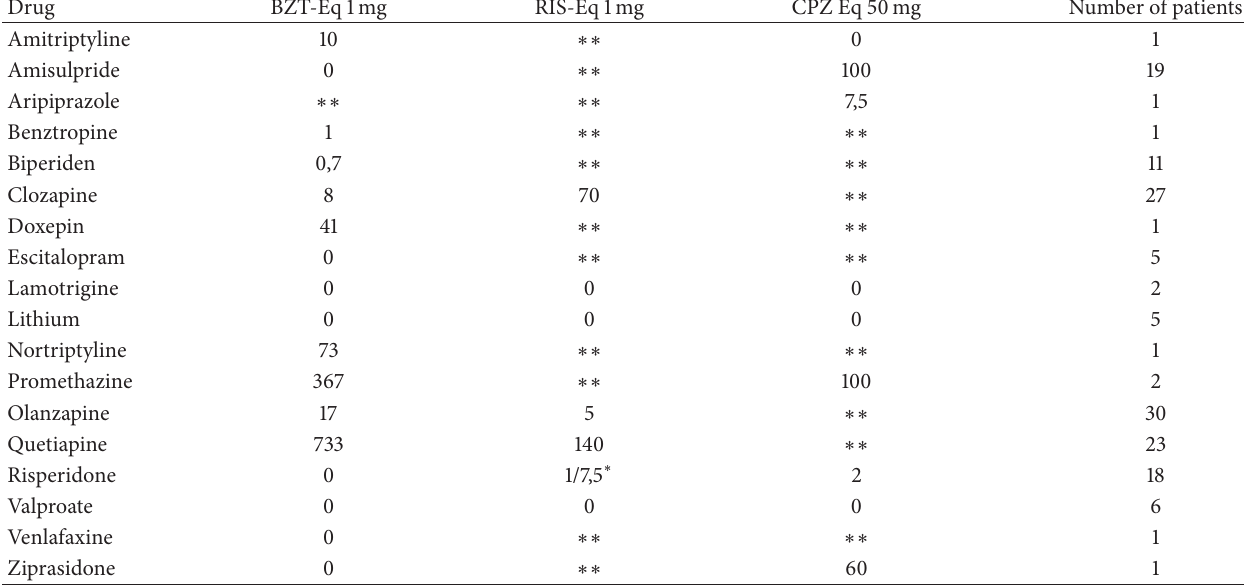
Table 2: Dose equivalences for antipsychotic (RIS-Eq/CPZ-Eq) and anticholinergic (BZT-Eq) medication. Drug BZT-Eq